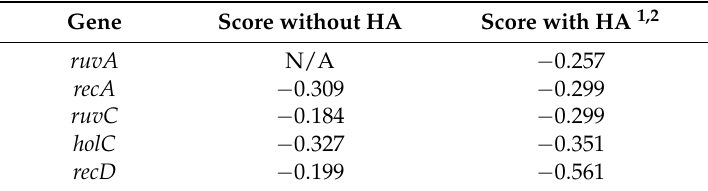
Table 3. Hydroxyurea sensitive and gene hits involved in the synthesis of DNA, normalized to include only the effects of Ga exposure; those with a score two deviations from the mean are